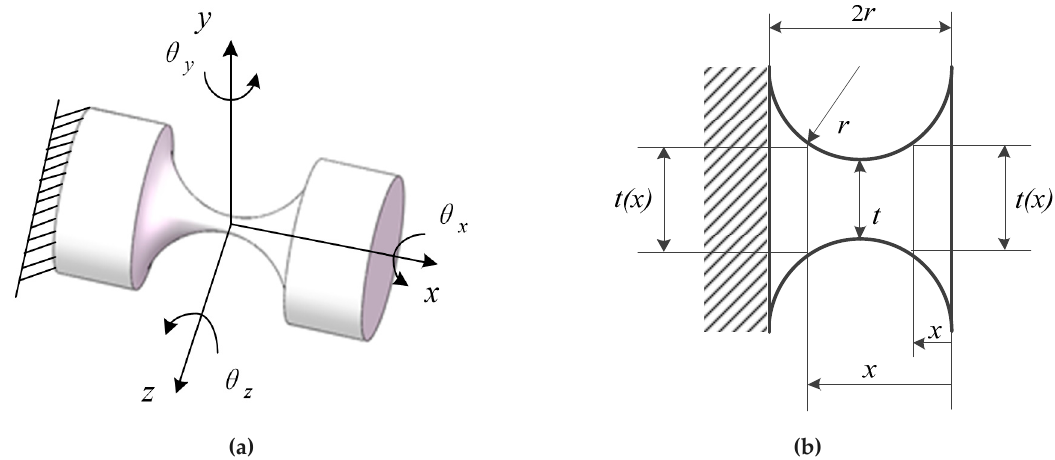
Figure 1. The model and geometry of an RCCS compliant spherical joint: ( a ) model of an RCCS; ( b ) geometry of an RCCS compliant spherical joint.